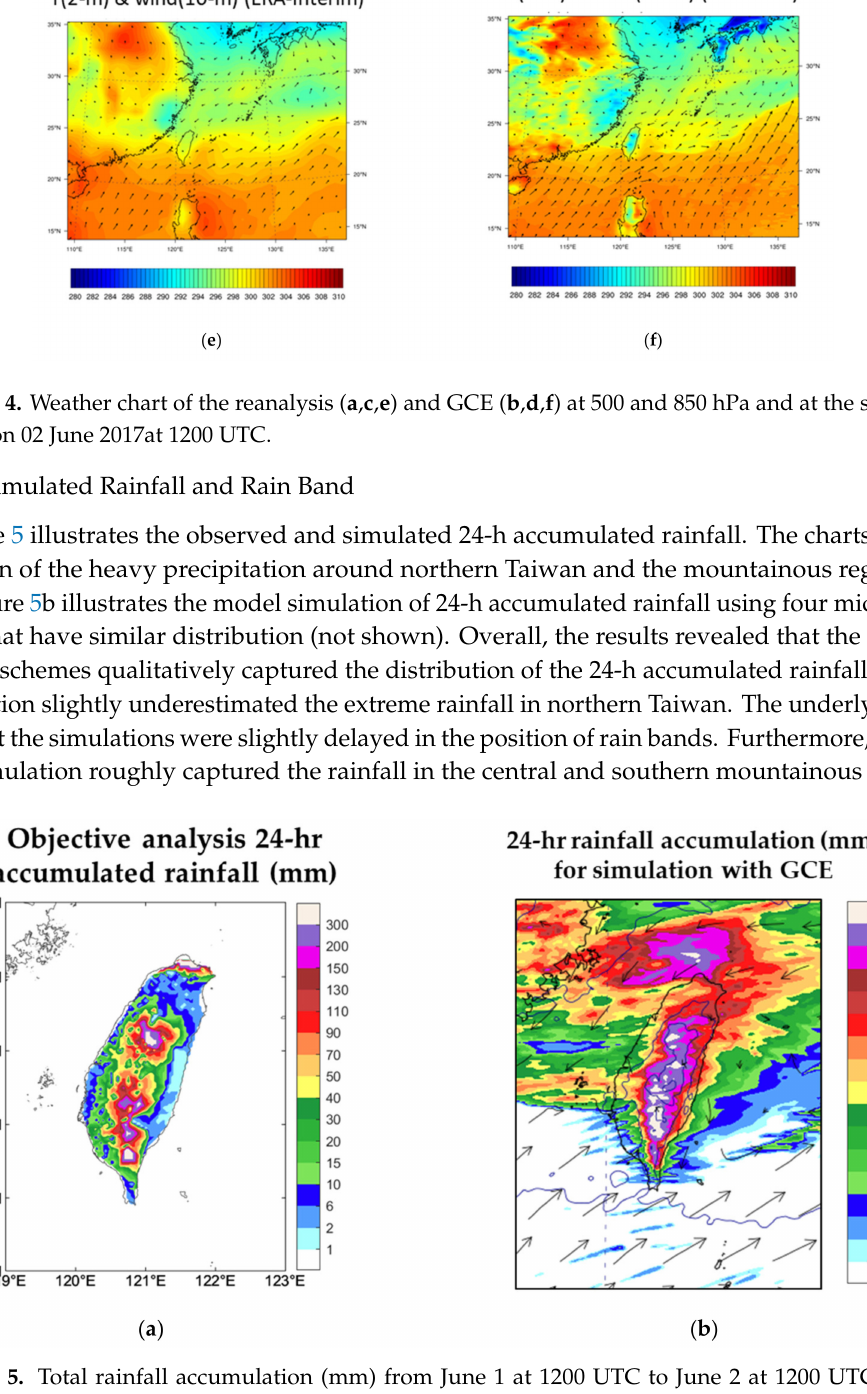
Figure 5. Total rainfall accumulation (mm) from June 1 at 1200 UTC to June 2 at 1200 UTC from ( a ) observation and ( b ) simulation with GCE in domain